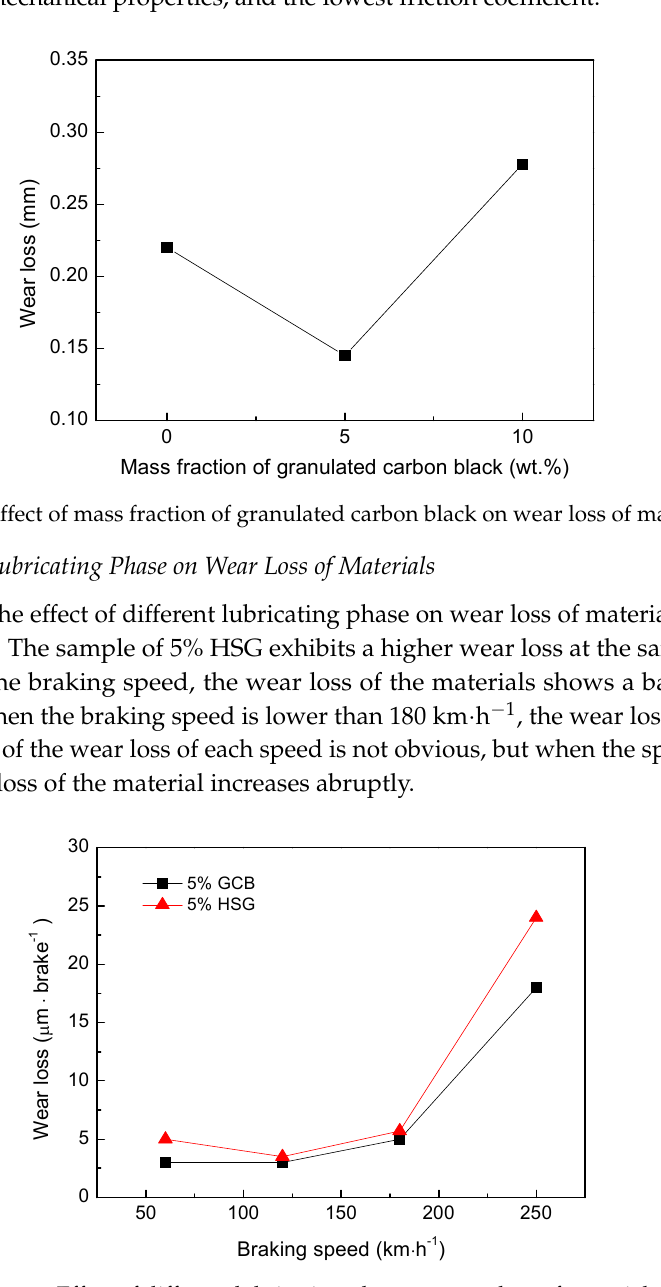
Figure 11. Effect of different lubricating phase on wear loss of materials.